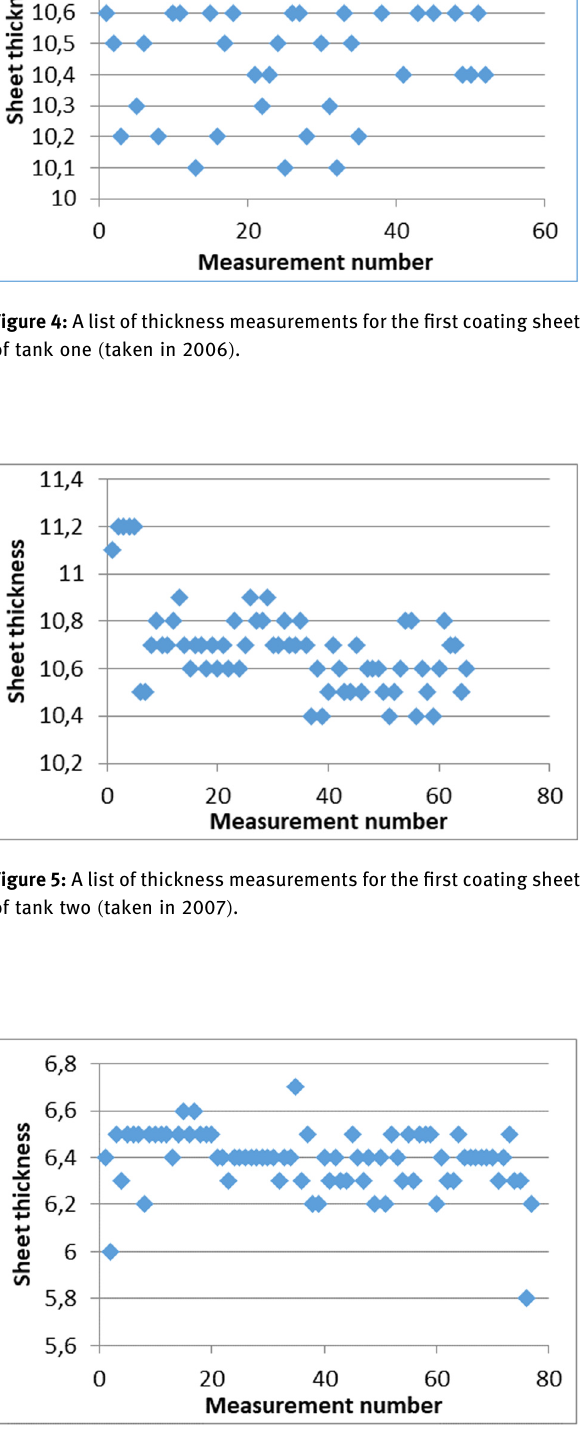
Figure 6: A list of thickness measurements for the fi rst coating sheet of tank 4 ( taken in 2001 ) .